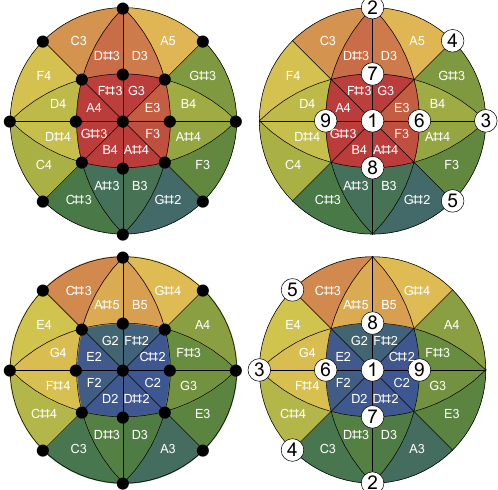
Figure 10. Image of the prototype of SphereHarmonic